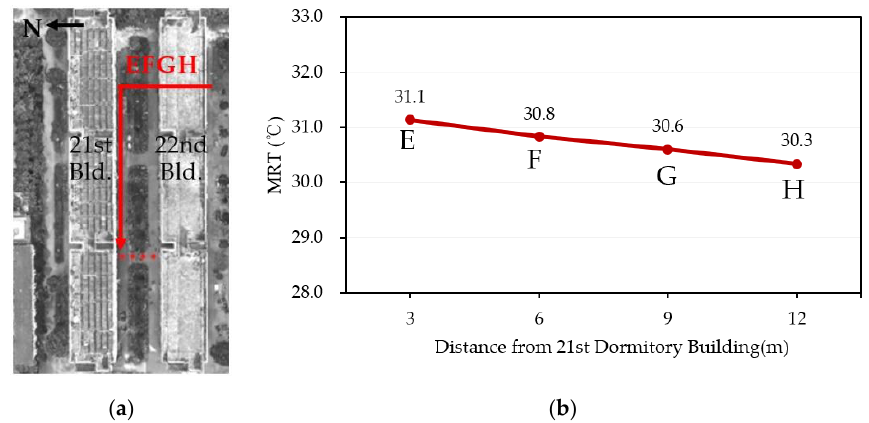
Figure 6. Locations and MRT values at analysis points E–H in the pedestrian space between the teaching buildings. ( a ) Locations of analysis points E–H; ( b ) MRT values at points E–H.